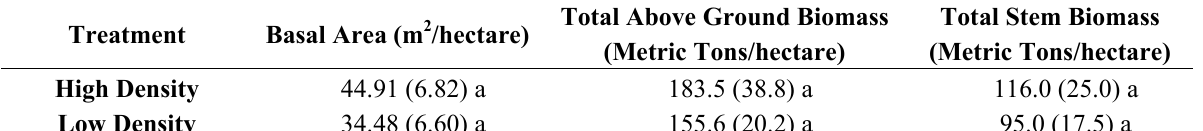
Table 3. Average (standard deviation) stand-level basal area, above ground biomass and stem biomass per hectare of red pine in the Huron National Forest, Michigan, between two density types. Different letters denote significant differences between density types ( p < 0.05).